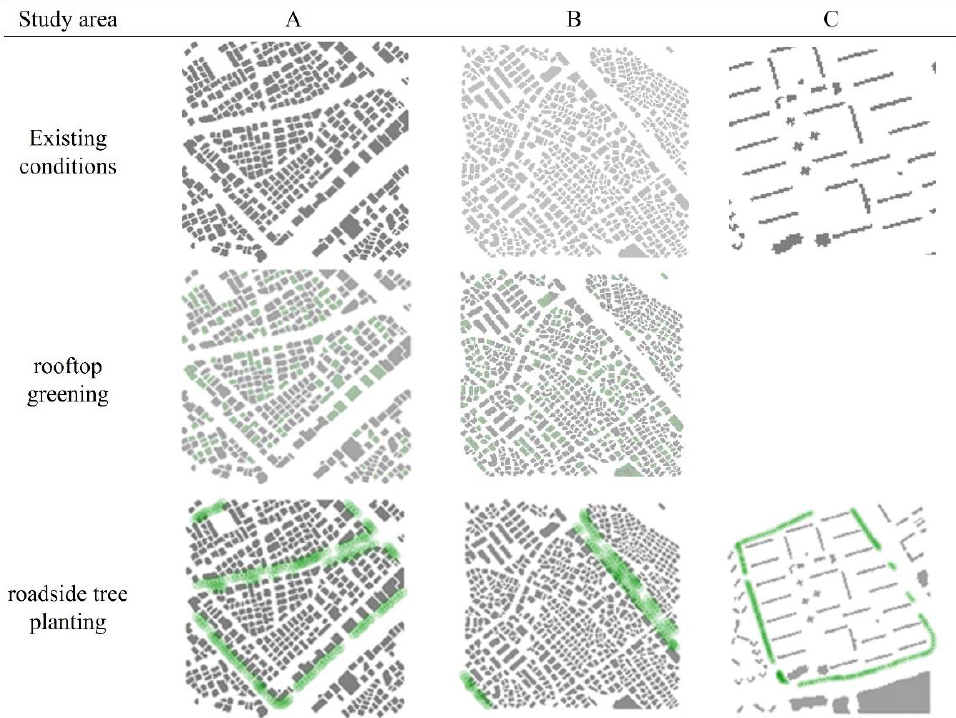
Figure 9. Scenarios for analysis of temperature reduction effects.